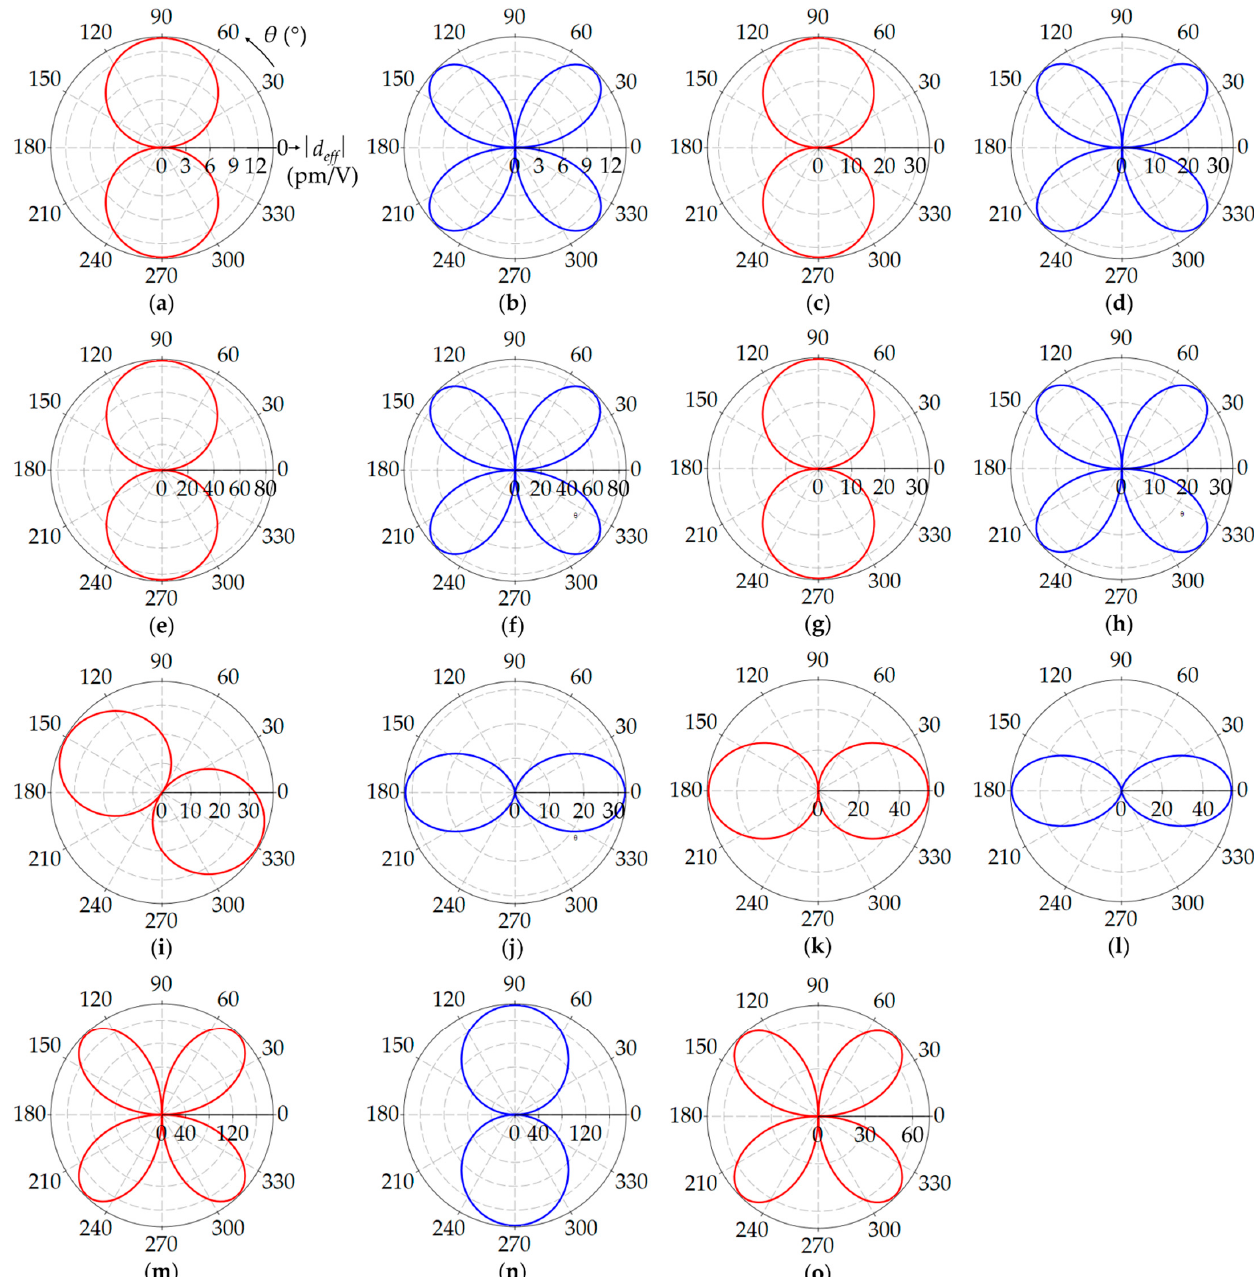
Figure 5. The polar-plots of the d eff values shown as a function of θ , which were numerically calculated using the analytical equations for chalcopyrite uniaxial crystals in Table 4. ( a ) Type I and ( b ) Type II in AGS; ( c ) Type I and ( d ) Type II in AGSe; ( e ) Type I and ( f ) Type II in CSP; ( g ) Type I and ( h ) Type II in HGS; ( i ) Type I and ( j ) Type II in TASe; ( k ) Type I and ( l ) Type II in GaSe; ( m ) Type I and ( n ) Type II in CGA; and ( o ) Type I in ZGP.